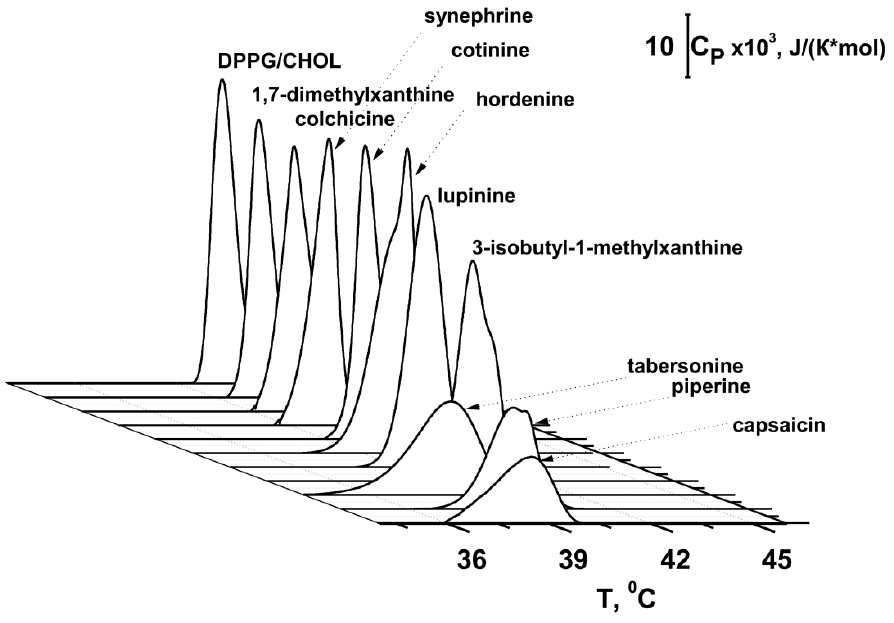
Figure 3. Heating thermograms of DPPG/CHOL (90/10 mol%) liposomes in the absence and pres- ence of 400 µ M of 1,7-dimethylxanthine, piperine, hordenine, cotinine, 3-isobutyl-1-methylxanthine, lupinine, synephrine, capsaicin, colchicine, and 40 µ M of tabersonine .